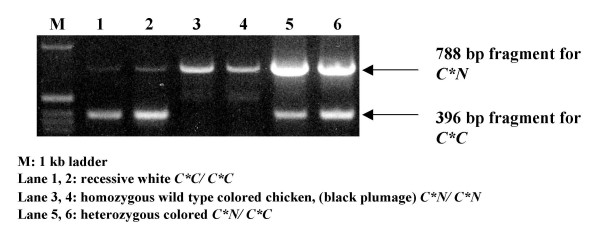
RT-PCR detection of aberrant and normal-sized transcripts of the TYR gene. The major transcript in the recessive white genotype was the truncated transcript (lane 1, 2) and the major transcript in the heterozygous colored chicken was the normal sized transcript (lane 5, 6). There was no aberrant transcript in the homozygous black plumage chickens (lane 3, 4).